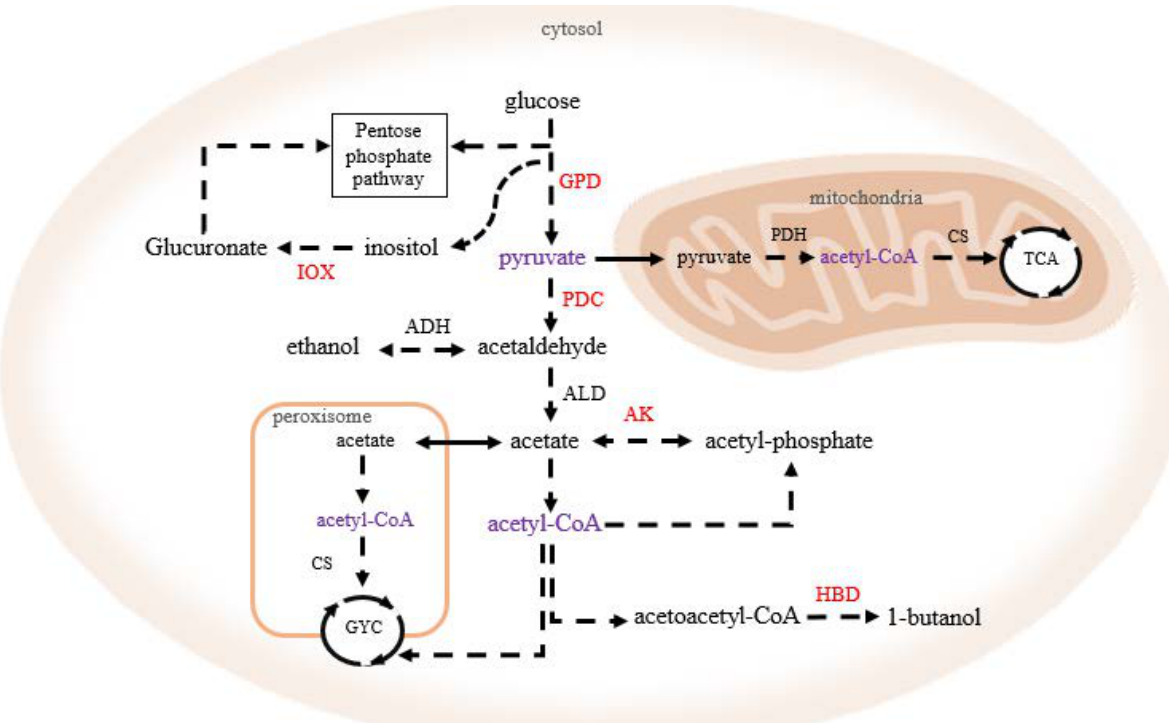
Figure 7. Proposed diagram of unique proteins involved in carbohydrate metabolism of C. neoformans in response to r-javanicin. Based on the proteomics analysis, many of fungal enzymes associated with carbohydrate catabolism after r-javanicin treated are identified (red letters) such as glyceraldehyde-3-phosphate dehydrogenase (GPD), pyru- vate decarboxylase (PDC), 3-hydroxybutyryl-CoA dehydrogenase (HBD), inositol oxygenase (IOX), and acetated kinase (AK). Purple letters are the intermediate molecules. Some enzymes in the pathway including alcohol dehydrogenase (ADH), acetaldehyde dehydrogenase (ALD), citrate synthase (CS) and pyruvate dehydrogenase (PDH) are also indicated. TCA = Tricarboxylic acid cycle; GYC = Glyoxylate